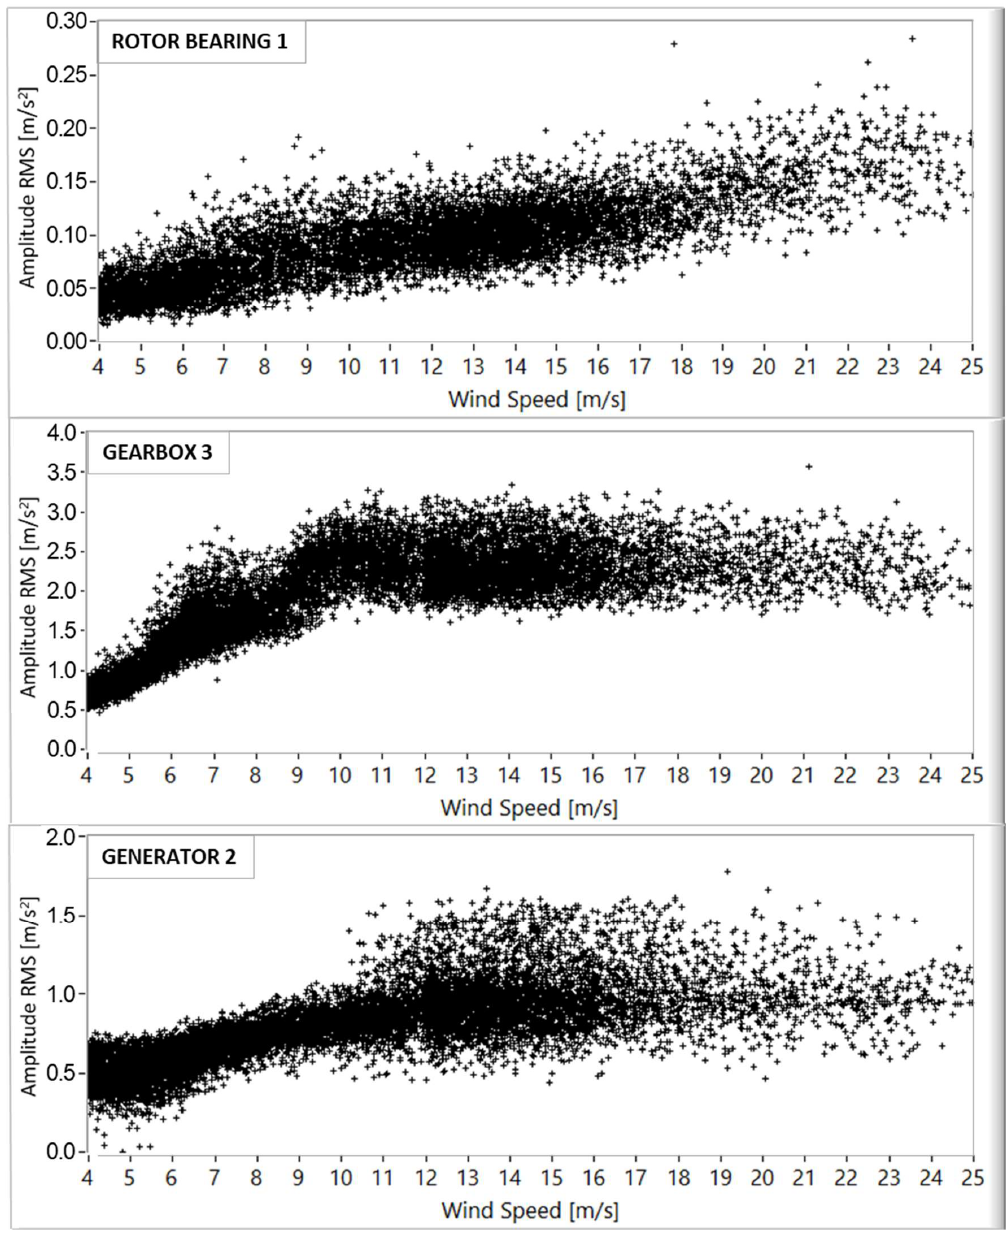
Figure 11. Broad band RMS vibration amplitudes as a function of wind speed.